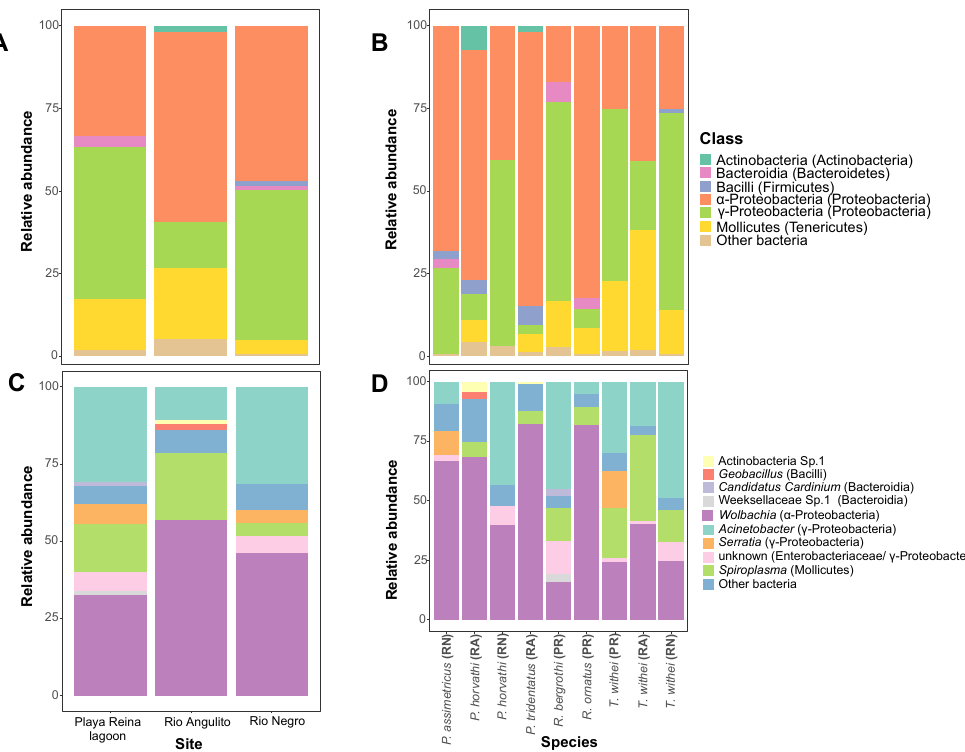
Figure 2. Relative abundance of dominant bacteria taxa associated with water striders. Abundance was estimated at the level of bacterial class across sites ( A ) and species within sites ( B ), as well as at the level of genus across sites ( C ) and species within sites ( D ). Only bacterial taxa with > 5% sequence abundance are shown for both taxonomic levels.